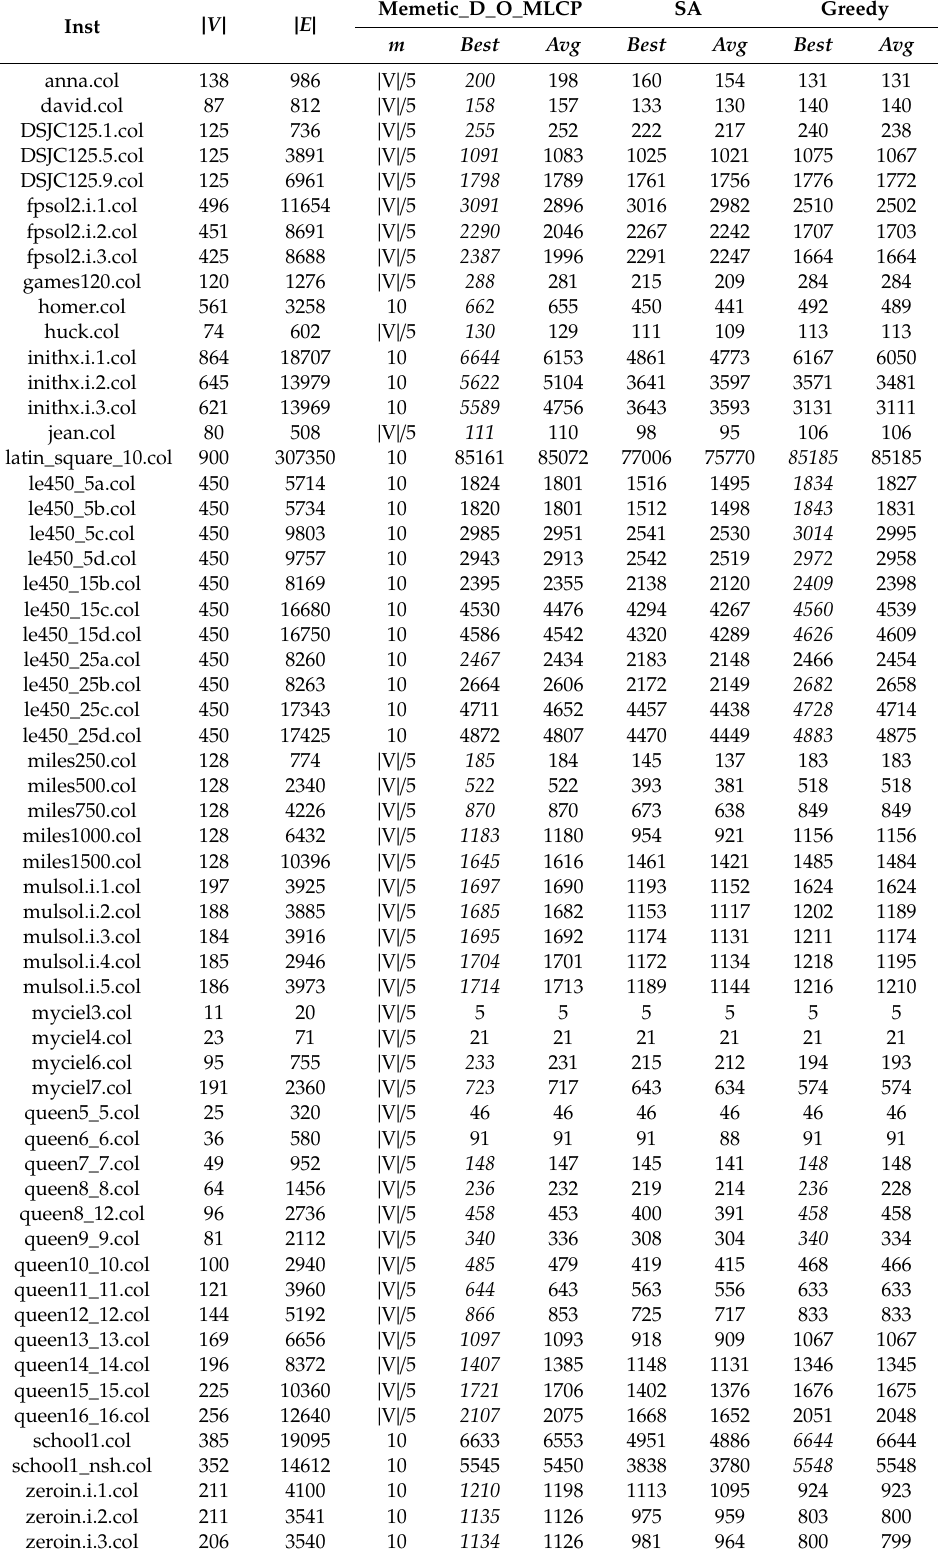
Table 2. Test results of the Memetic_D_O_MLCP, SA, and Greedy on benchmark instances. Inst | V | m